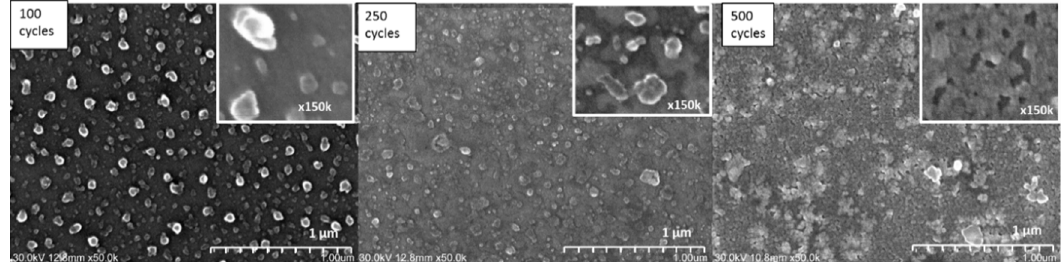
Figure 7. Scanning electron microscope (SEM) images of Ag 2 O thin films deposited with different number of cycles at 200 °C resulting in different thicknesses (5.8, 8.8, and 13.8 nm).